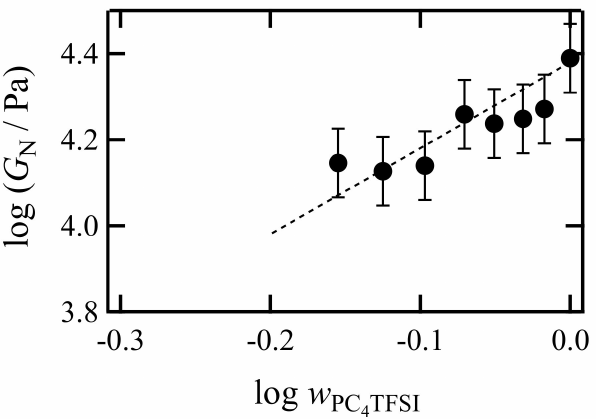
Figure 8. Dependence of plateau modulus G N on the weight fraction of PC 4 -TFSI, w PC PC 4 -TFSI/LiTFSI mixtures. The dotted line represents a straight line with a slope of 2.